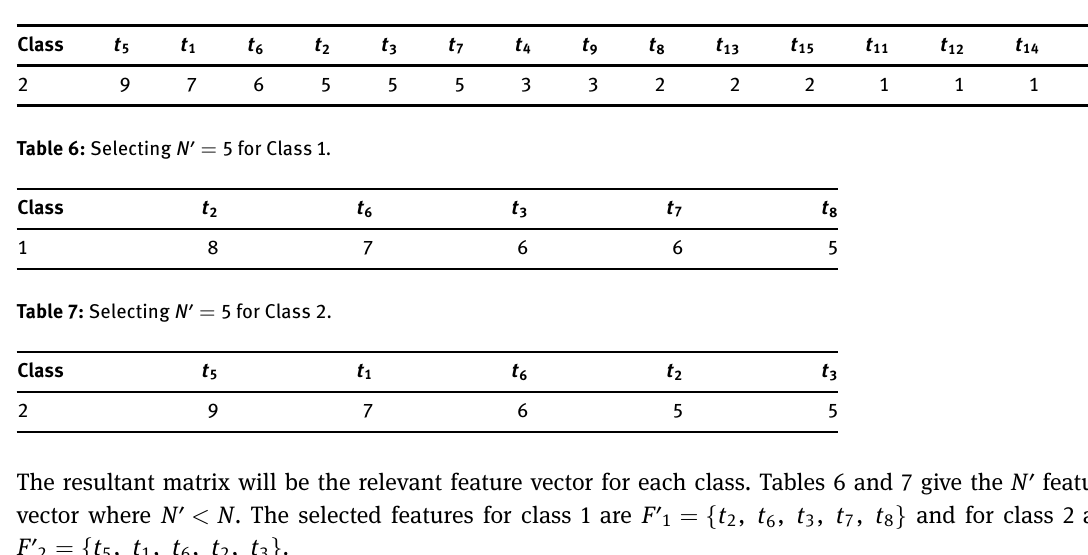
Table 5: Arranging ClassTermFrequency in Descending Order in Class 2.